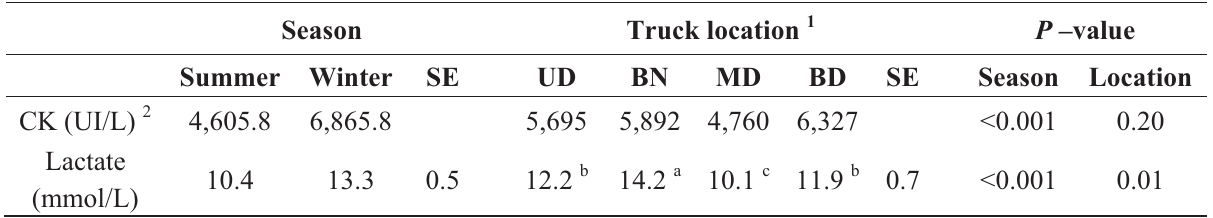
Table 3. Lactate and creatine kinase (CK) concentrations in exsanguination blood of pigs (n = 329) transported on the PB trailer according to the season and the truck